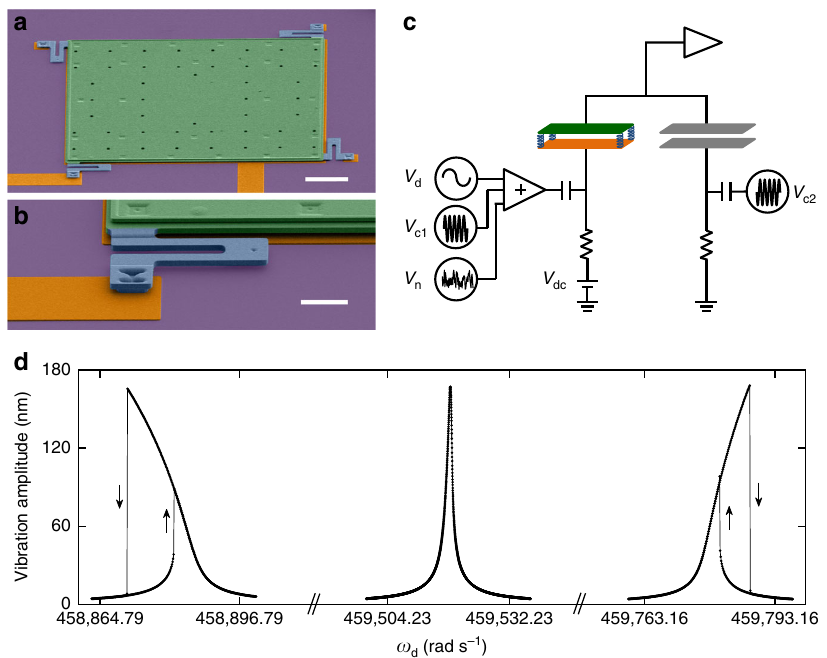
Fig. 1 Micromechanical trampoline resonator. a Colorized scanning electron micrograph of the resonator that consists of a movable silicon top plate (green) supported by serpentine springs (blue) at its four corners. The white scale bar measures 50 μ m. b A close-up on one of the four springs at a corner. The scale bar measures 15 μ m. c Simpli fi ed schematic showing the electrostatic actuation and detection of vibrations of the top plate using a capacitance bridge. d The electrostatic contribution to the Duf fi ng nonlinearity can be controlled by V dc. Measured vibration amplitude is plotted as a function of driving frequency for a fi xed driving force amplitude and three different V dc : − 2.3, − 1.6, and − 1.2 V from left to right, where the Duf fi ng nonlinearity changes from positive to near zero to